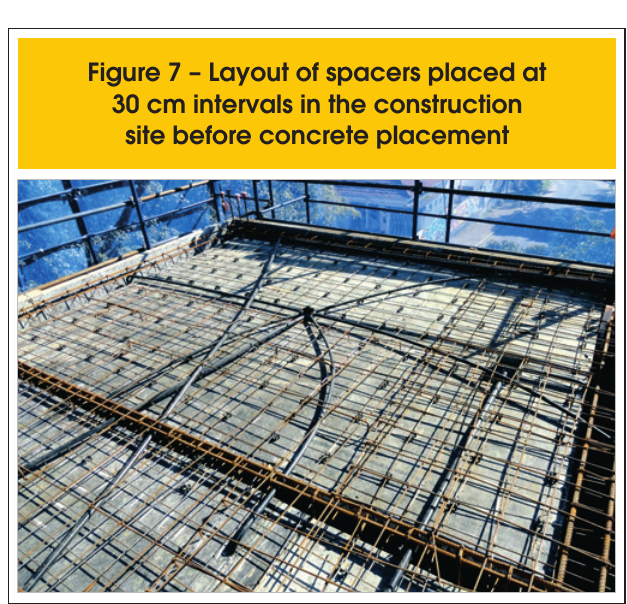
Figure 5 – Tying points 15 cm apart with spacers 30 cm apart